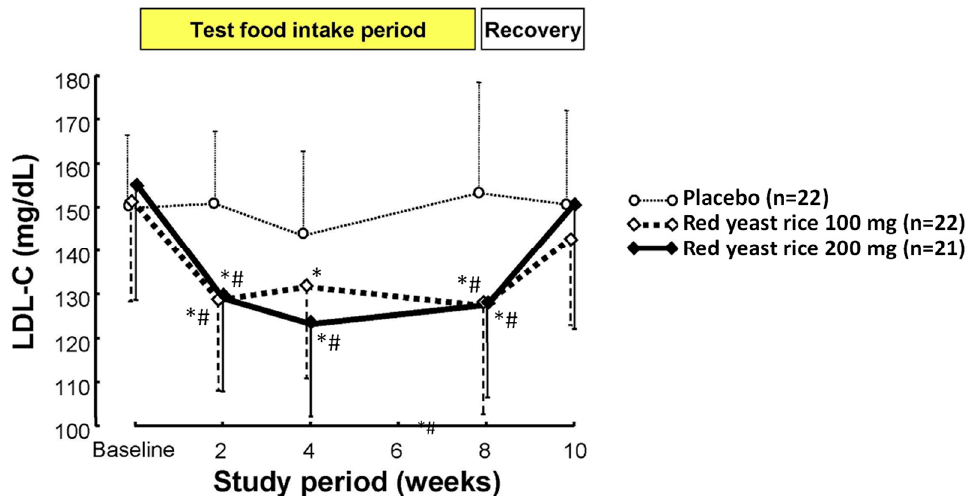
Figure 13. Effect of intake of red yeast rice produced by solid-state fermentation in normal healthy volunteers whose plasma cholesterol levels were 120 mg/dL or higher. Each bar indicates the mean ± standard deviation. *: Significant difference from start of ingestion ( p < 0.05, paired ANOVA). #: Significantly different from the placebo group ( p < 0.05, multiple comparison using Bonferroni).